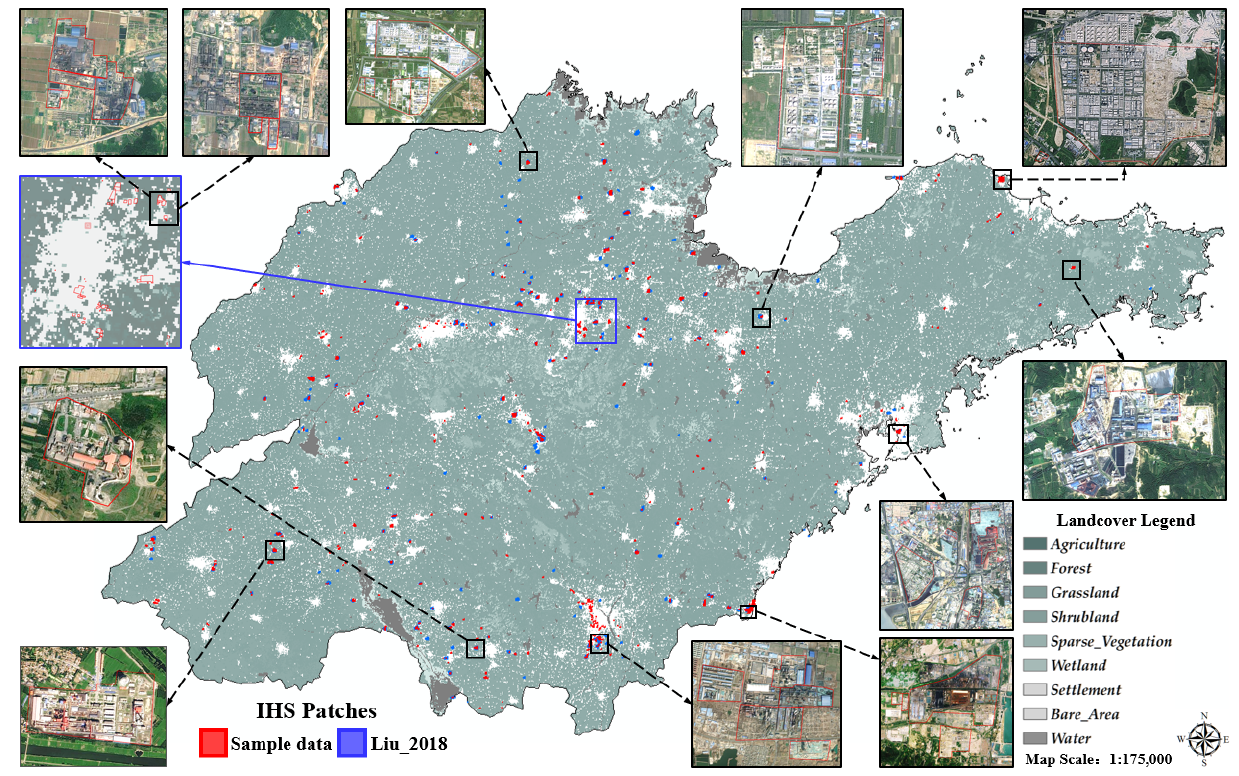
Figure 3. The spatial distribution of the reference industrial heat source (IHS) patches (i.e., sample data and Liu_2018 data) applied in this study. The snapshots show the boundaries of our sampled data and corresponding high-resolution images.